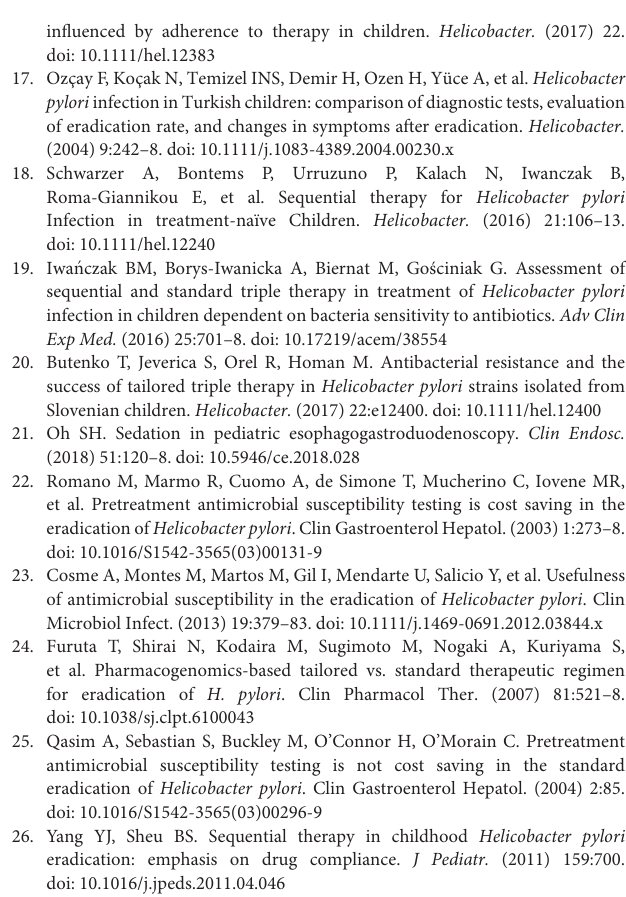
Supplementary Table 1 | The direct and indirect costs of diagnosis and treatment for children with H. pylori infection according to the two eradication strategies in